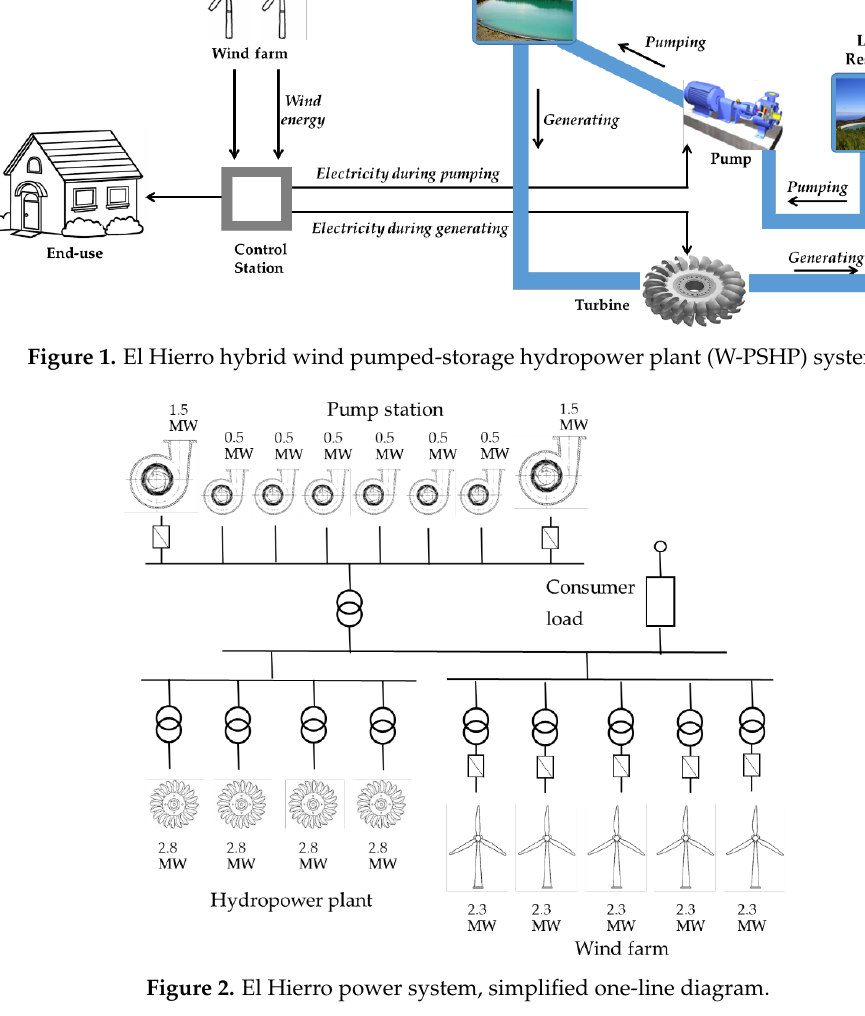
Figure 2. El Hierro power system, simplified one-line diagram.